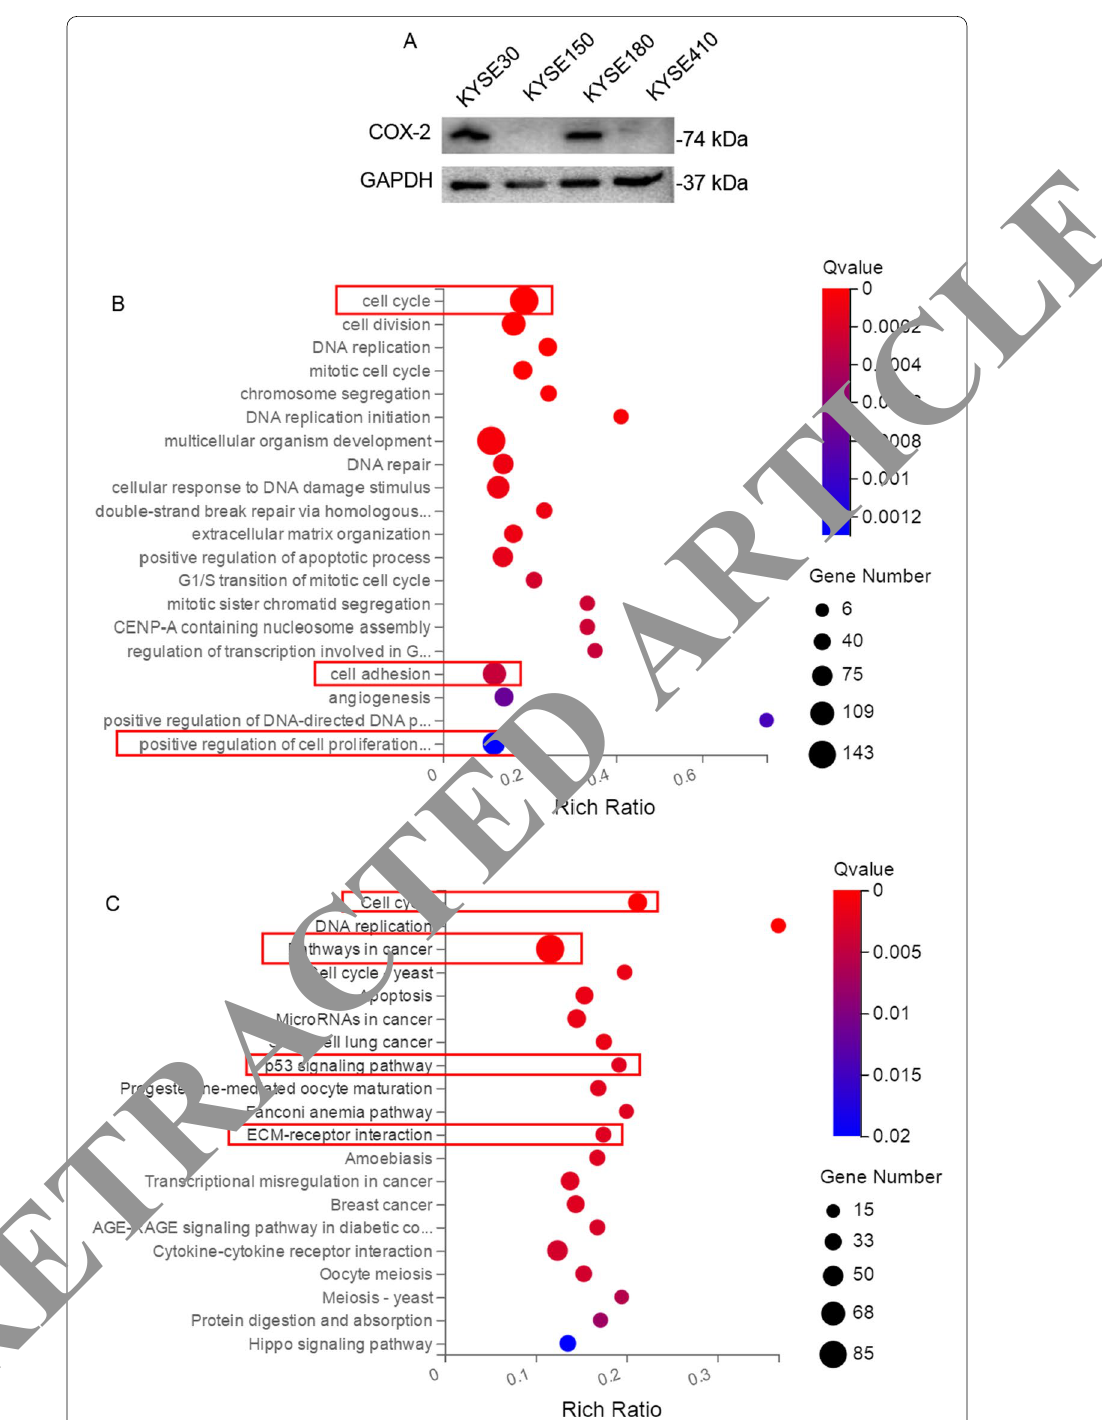
Fig. 1 Relative expression of COX‑2 in ESCC cell lines and prediction for function or mechanism after treatment with parecoxib. A Relative expression of COX‑2 was measured in four ESCC cell lines by western blotting. B GO analysis of differentially expressed mRNA after treatment with parecoxib (300 μM), suggesting variation in cell cycle, proliferation, and cell adhesion. C KEGG analysis of pathways enriched for differentially expressed mRNA, indicating variation in cell cycle, ECM, p53, and pathways in